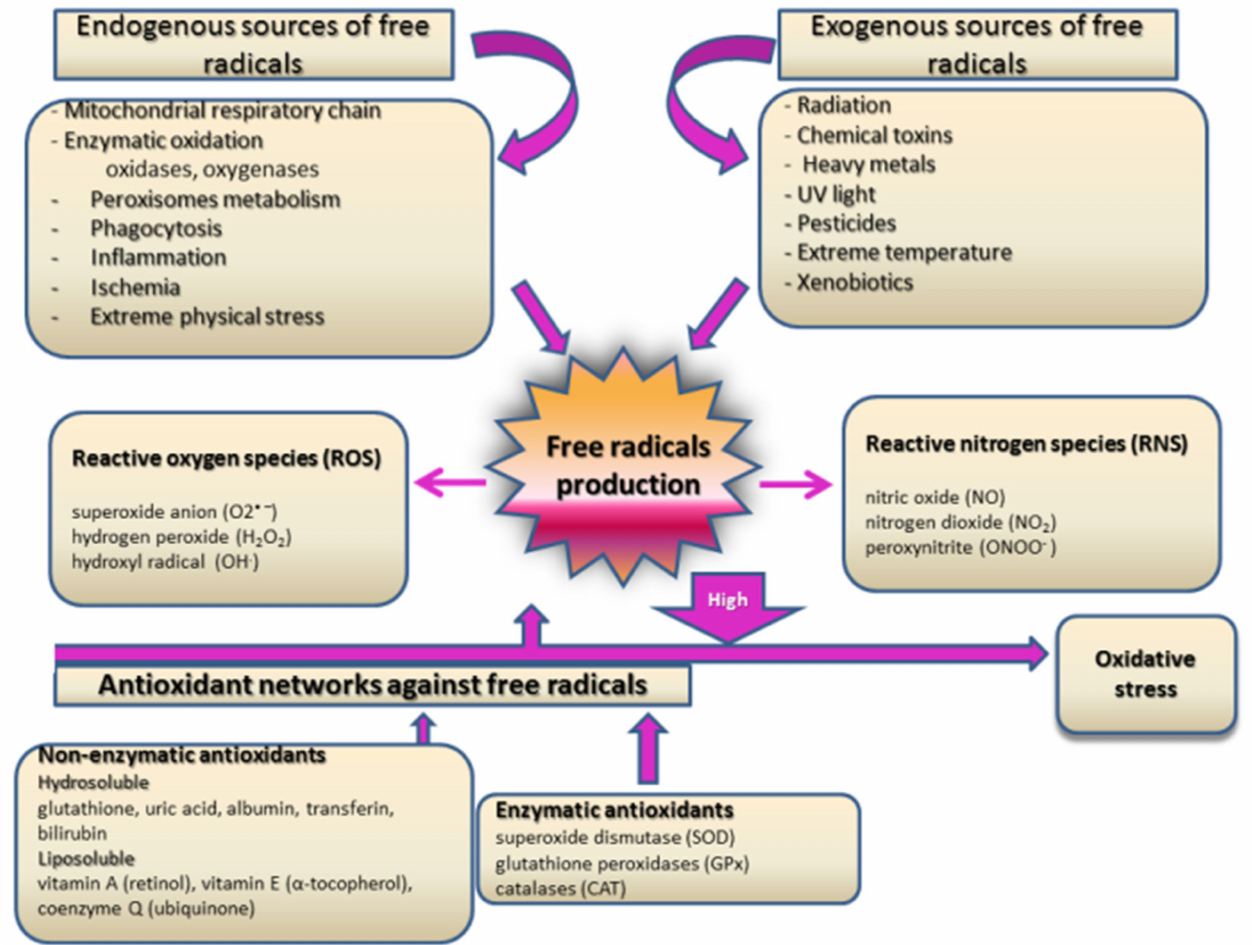
Figure 3. Major sources of free radicals and main